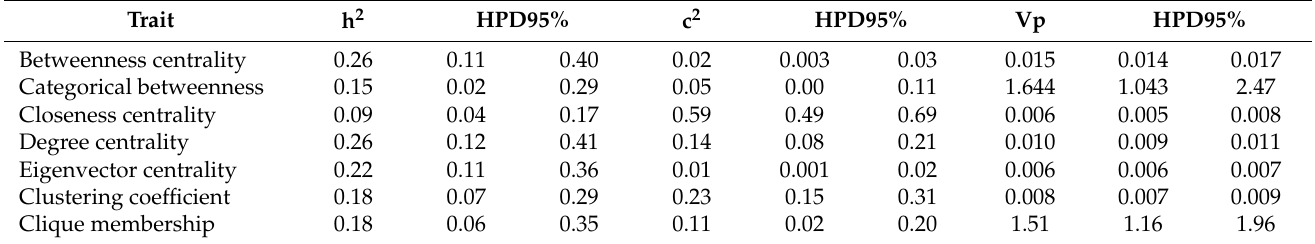
Table 3. Posterior means of heritability (h 2 ), the phenotypic proportions of the variance due to the environmental pen effects (c 2 ), and the phenotypic variances (Vp), and the 95% highest posterior density intervals (HPD95%) for social network analysis traits for aggressive